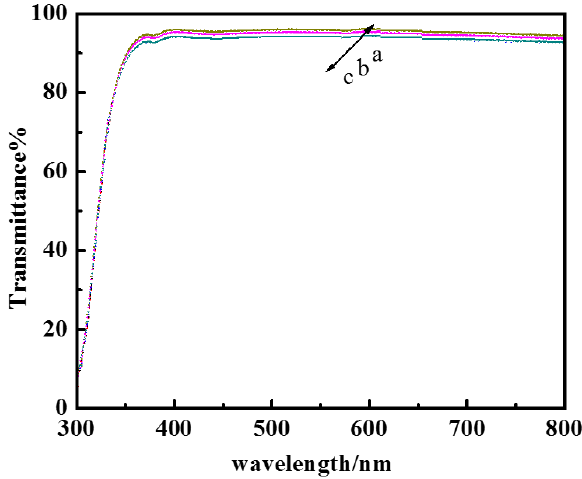
Figure 12. Transmittance of the coatings: ( a ) blank; ( b ) FSi@SiO 2 ; ( c ) FVPS.